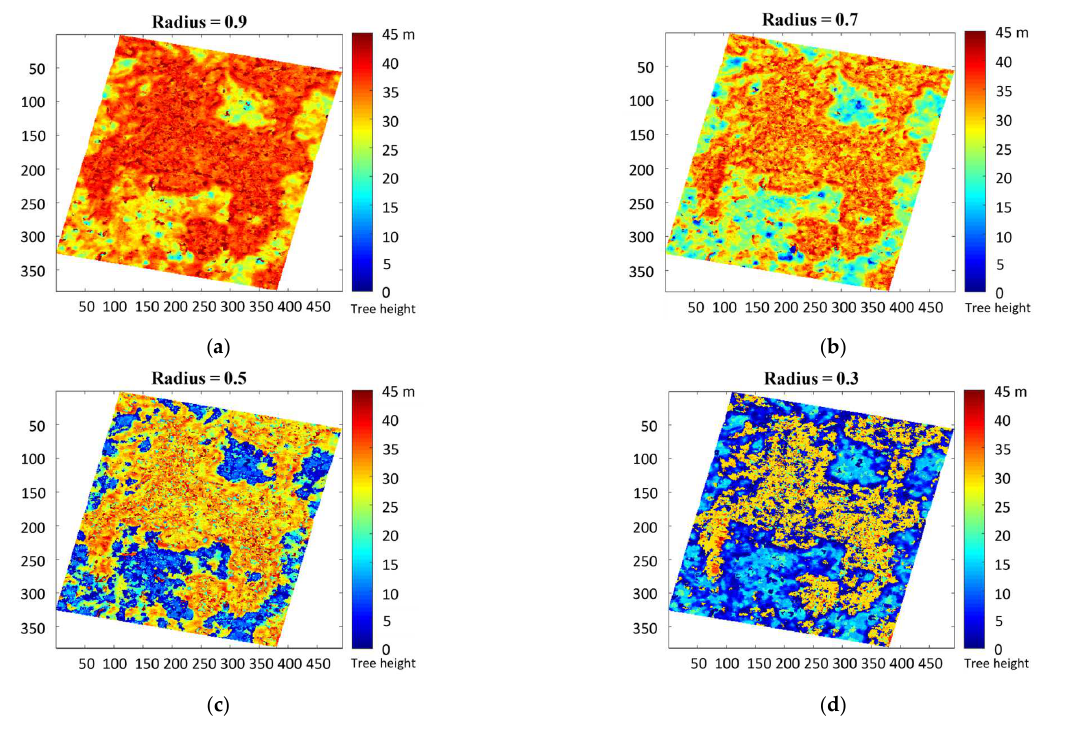
Figure 7. Forest height maps derived from the DF-RMoG method with different compensation fac- tor values (temporal baseline of 92 days). ( a ) Compensation factor value: 0.9, ( b ) Compensation fac- tor value: 0.7, ( c ) Compensation factor value: 0.5, ( d ) Compensation factor value: 0.3.